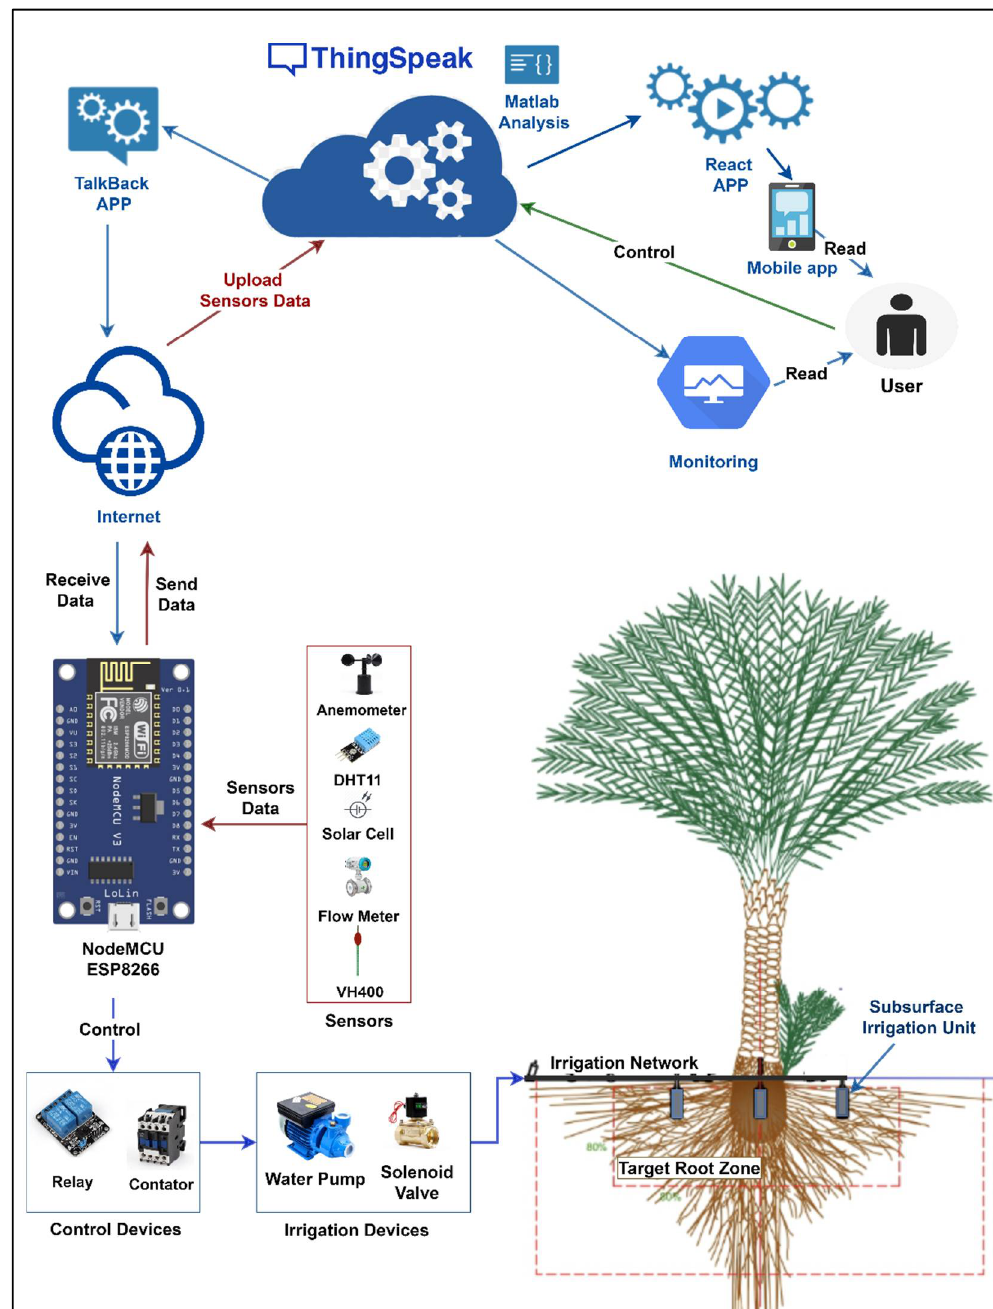
Figure 4. The designed controlled subsurface irrigation system (CSIS) was deployed around a date palm tree in our experimental field.